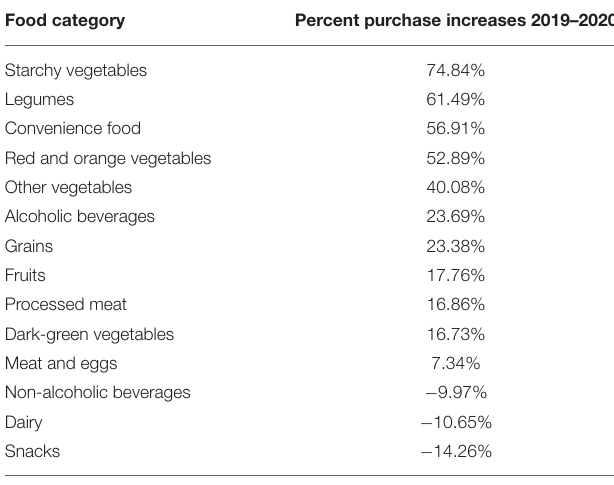
TABLE 4 | Increases in customer food purchases per food category (index based on nominal US$ sales prices), comparing average monthly purchases in March